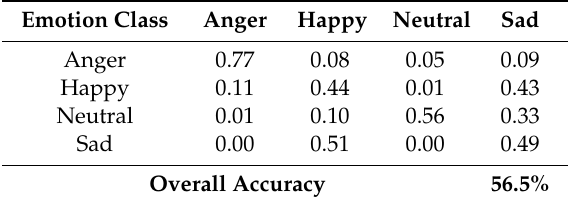
Table 7. Confusion matrix for emotions prediction on cross corpus between IEMOCAP and